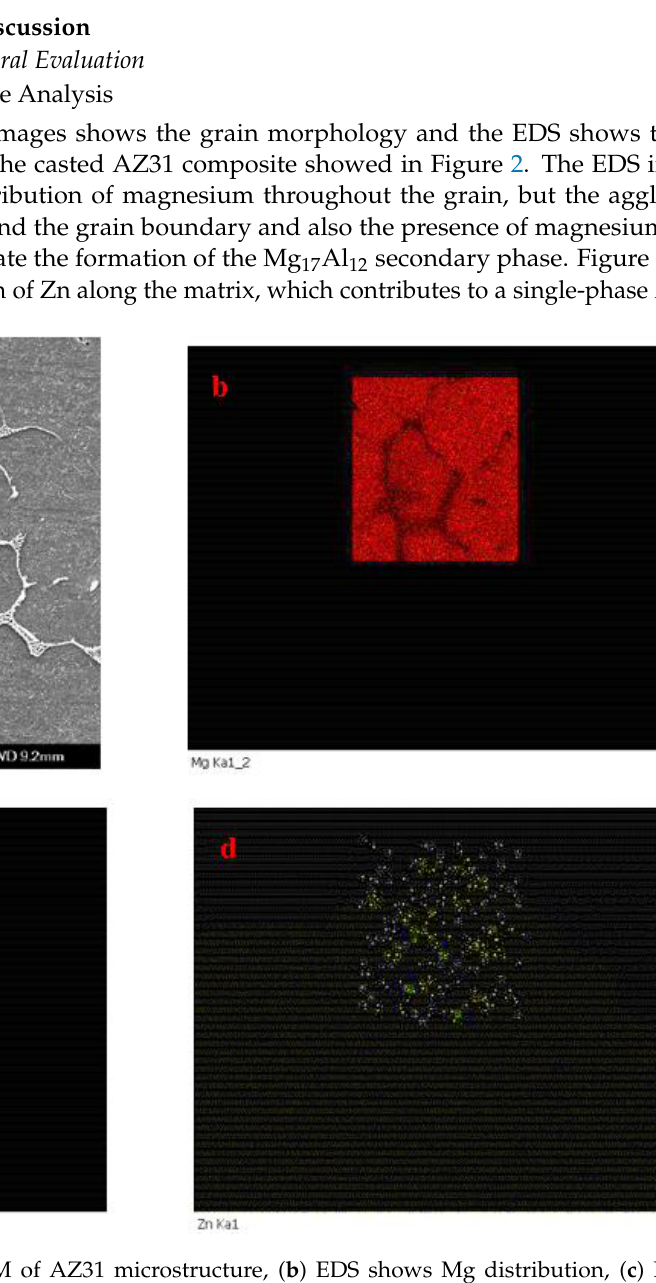
Table 1. Composition of AZ31 and reinforcement. Types of Cast Ingots